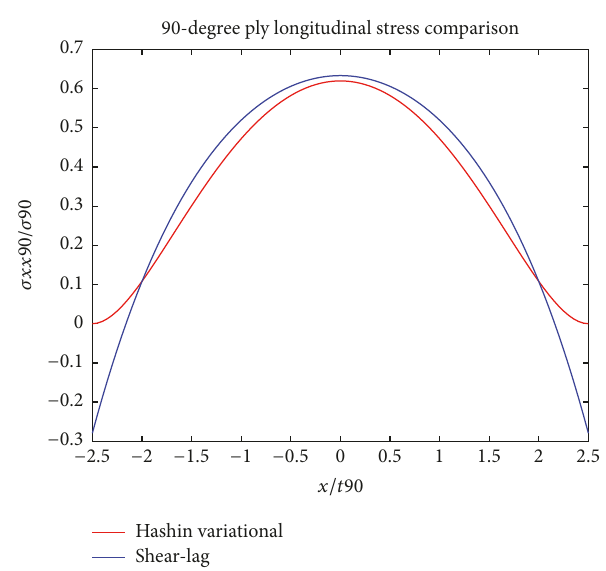
Figure 6: Comparison of longitudinal stress obtained by shear-lag and variational methods for 90-degree ply in a glass fiber/epoxy cross-ply [0/90] s composite under longitudinal